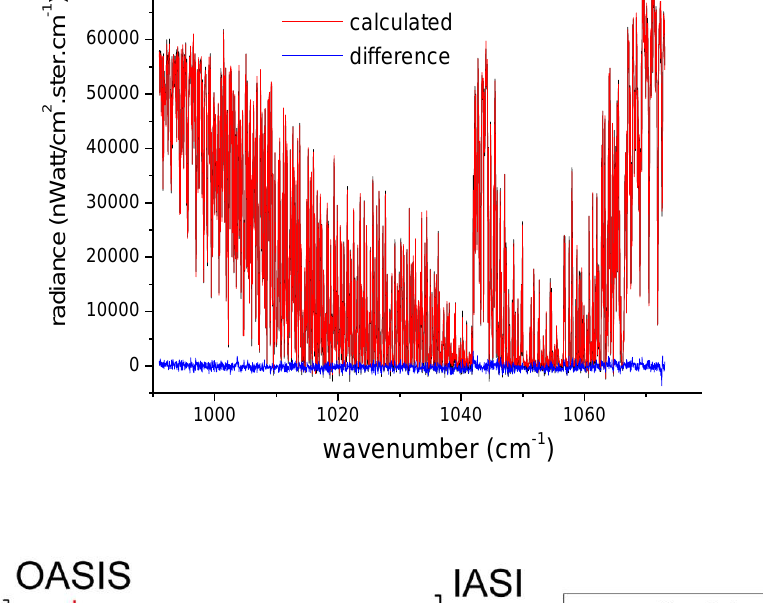
absorption bands around 10 microns. 319 3